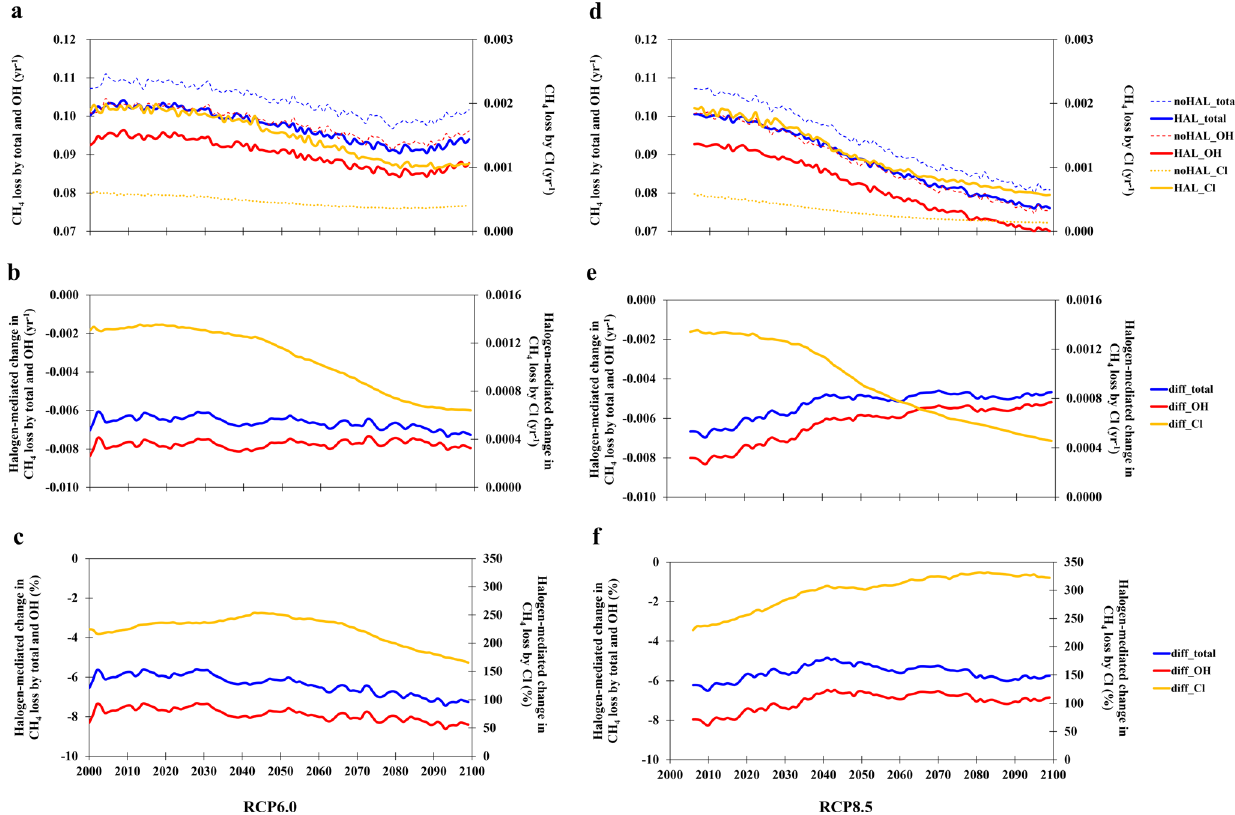
Fig. 3 Evolution of halogen-mediated change in global CH 4 loss rate during the 21st century for RCP6.0 (panels a, b, and c on the left) and RCP8.5 (panels d, e, and f on the right) scenarios. a , d The total CH 4 chemical loss (yr − 1 ; blue line) and the CH 4 loss (yr − 1 ) with respect to tropospheric OH (red line) and Cl (yellow line) radicals in both noHAL (dashed line) and HAL (solid line) cases. b , e Halogen-mediated change in CH 4 loss in yr − 1 for the total (blue), OH (red), and Cl (yellow) channels. c , f The same as ( b , e ) but in percentage. Note that the halogen-mediated changes are calculated with a moving average of 10 years (approximately the lifetime of CH 4 in the atmosphere). The halogen-mediated changes in CH 4 loss rates via total channels and the OH channel are negative (left Y -axis on panels b , c , e , f ) while those via the Cl channel are positive (right Y